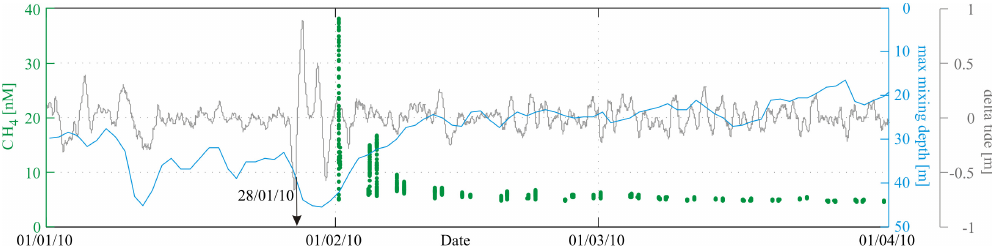
Fig. 4. Data from a three month survey of the Arkona Basin. Sea surface methane concentrations (green dots, representing measured methane concentrations along each leg crossing the selected area “Arkona Basin”, Table 1), daily maximum mixing depths (blue line) and sea level data (gray line, measured at station Sassnitz, Bundesanstalt f¨ur Wasserbau). Delta tide indicates the gradient of oscillation of the sea level around